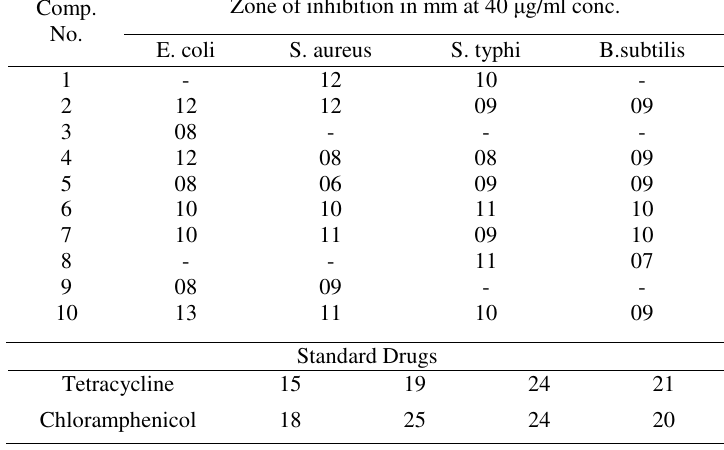
Zone of inhibition in mm at 40 (cid:1) g/ml conc.